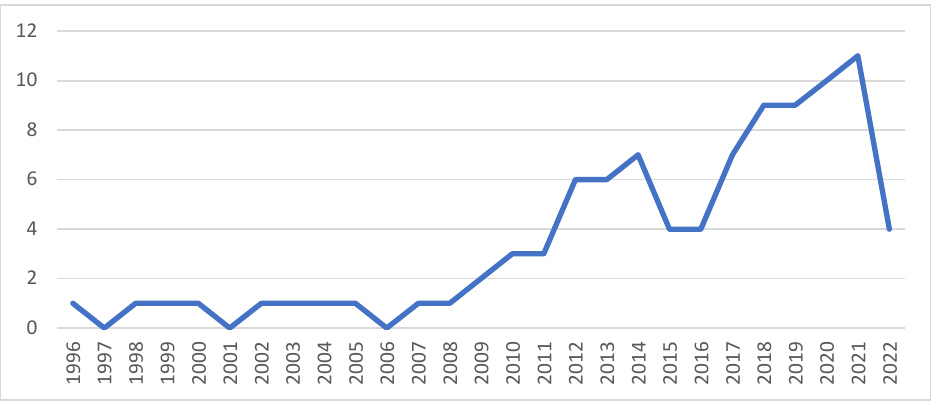
Figure 1. Articles per annum. Source: Author’s own, based on Web of Science search .